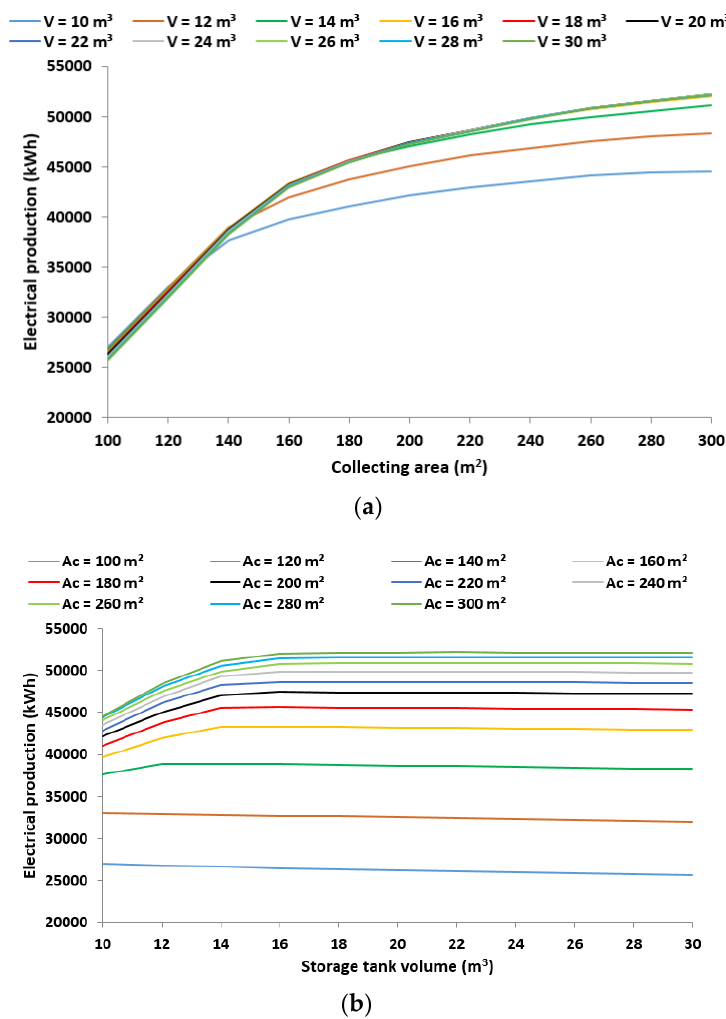
Figure 2. Electrical production ( a ) for different collecting areas with the storage tank volume as the main parameter ( b ) for different storage tank volumes with the collecting area as the main parameter.